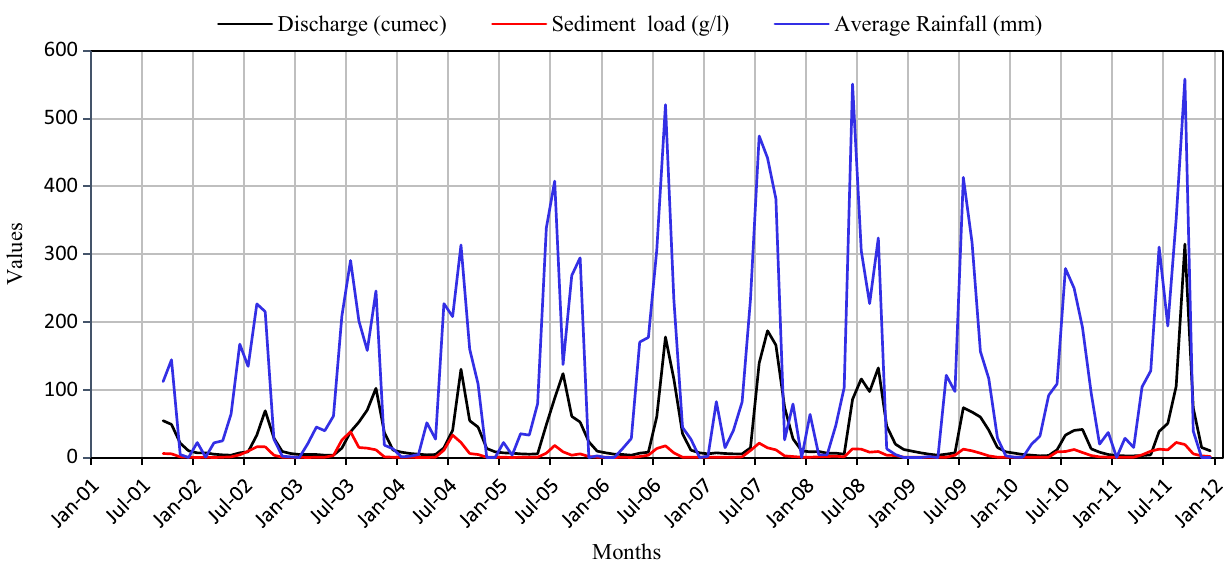
Fig. 5 Variation in monthly rainfall, discharge and sediment load of Champua watershed Table 6 Effect on runoff and sediment amount due to change in LULC from the year 2001 to 2011